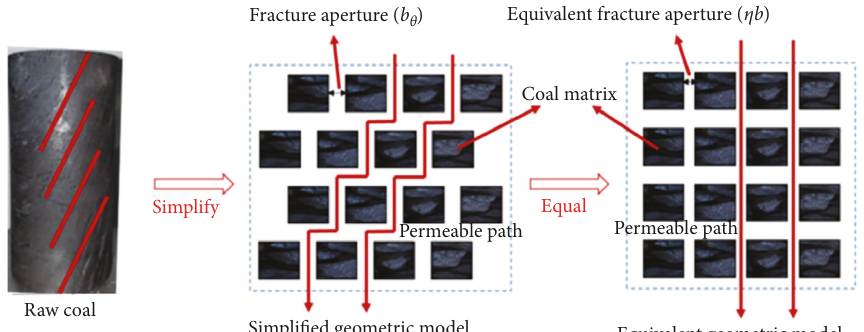
Figure 2: Schematic of simplified structure of